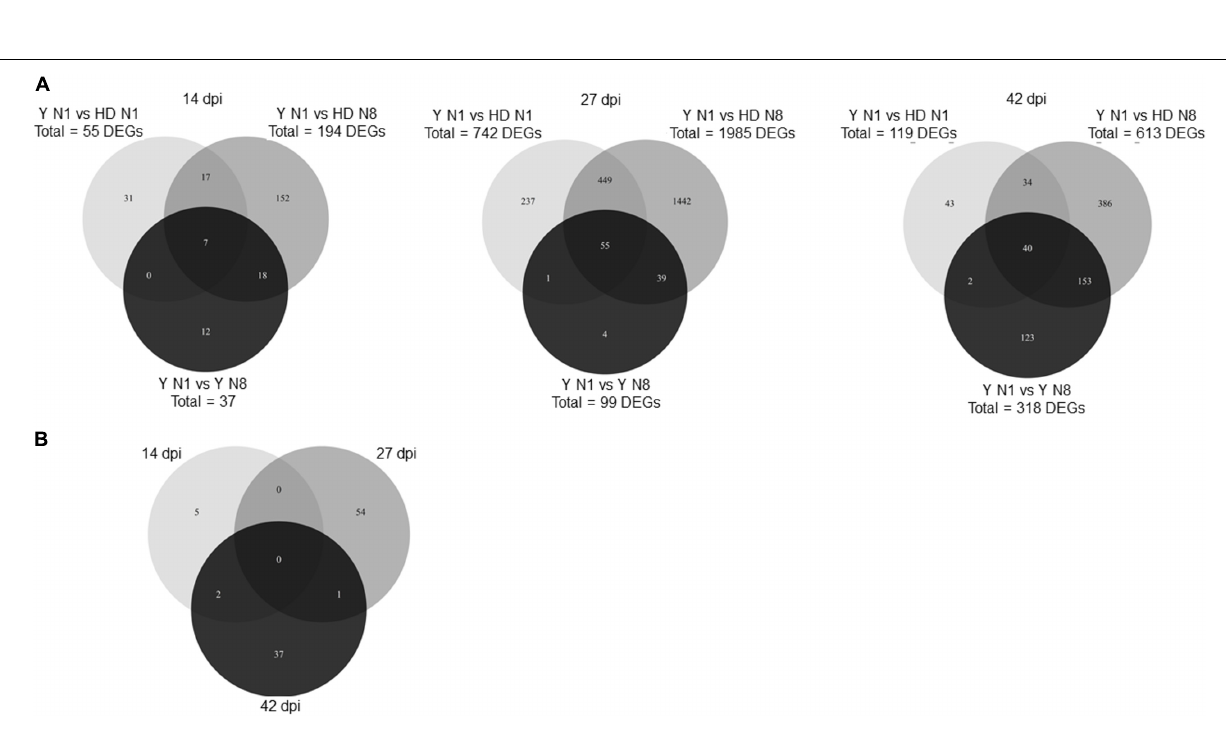
Frontiers in Microbiology |